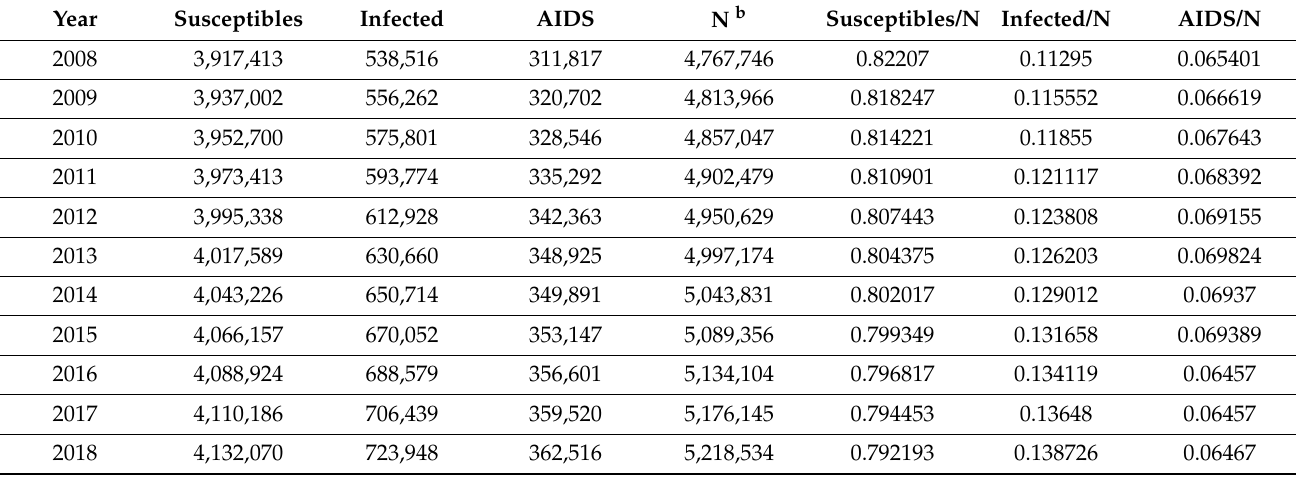
Table 1. CDC case surveillance data with normalization a